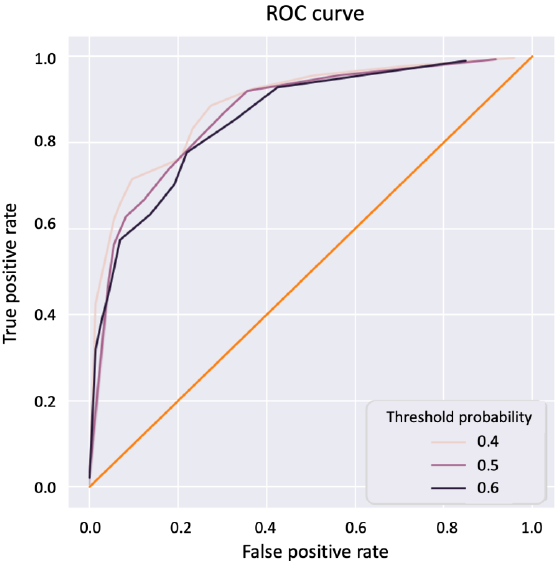
Figure 3. ROC-AUC curve to illustrate the deep learning model performance. An ROC-AUC curve was obtained by using a range of thresholds (0.4–0.6) on the positive probabilities and by using all thresholds between 0 and 5000 on the number of pixels necessary to classify a core as